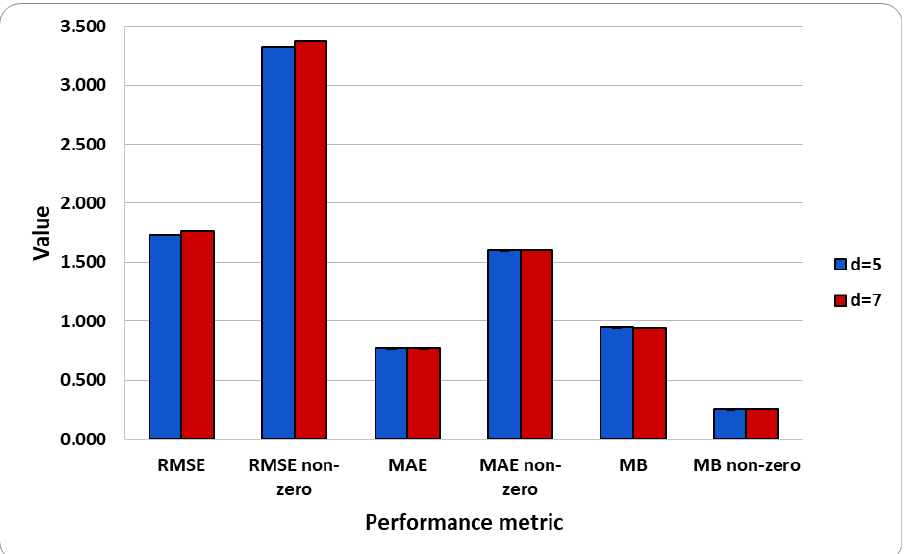
Figure 6. Performance metrics for the Stack PLS regressor for d = 5 and d = 7. The OX axis depicts the performance metrics employed for evaluation, while the values of these metrics obtained by the Stack PLS regressor are represented on the OY axis.